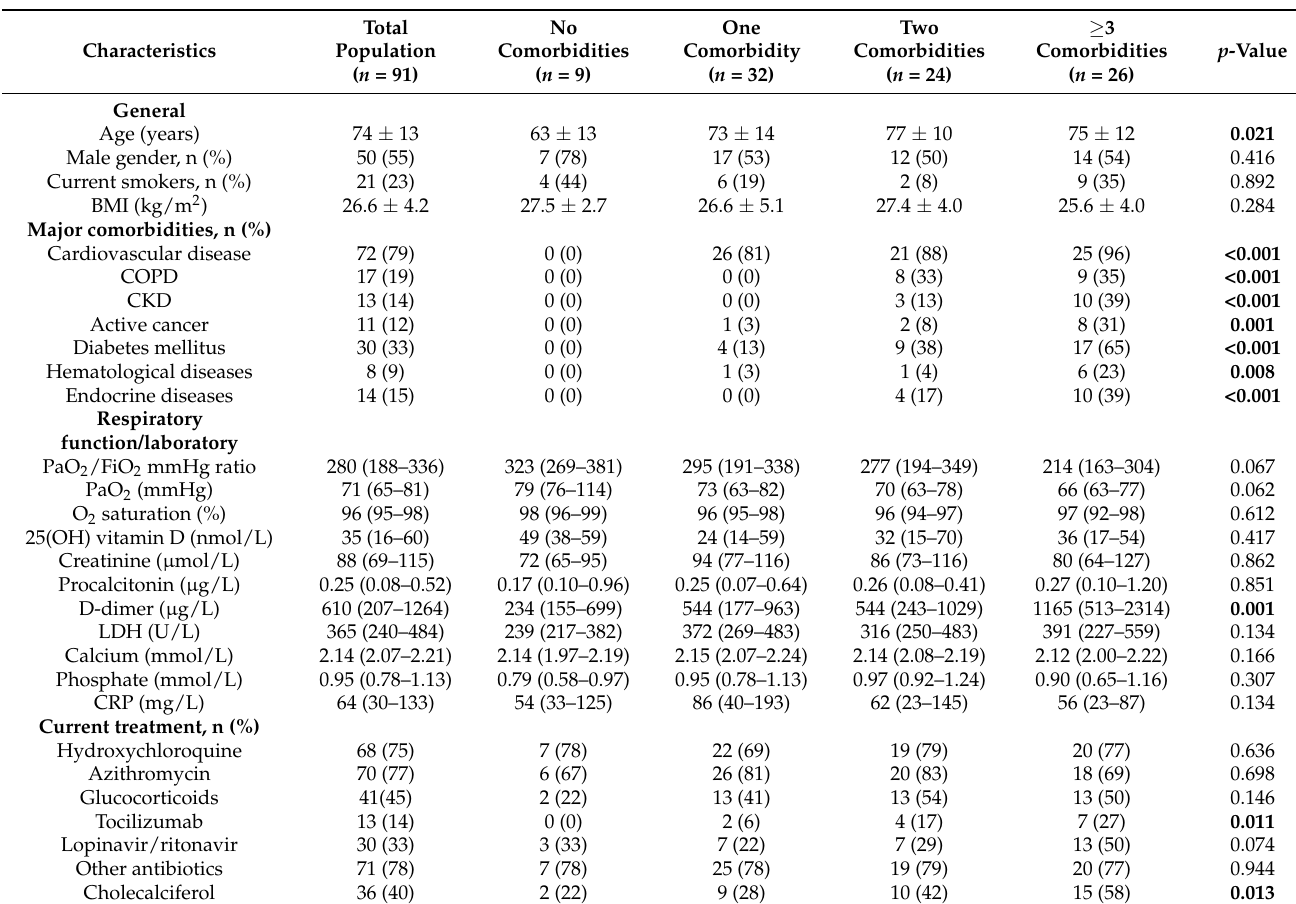
Table 2. Patient characteristics stratified by comorbidity burden.